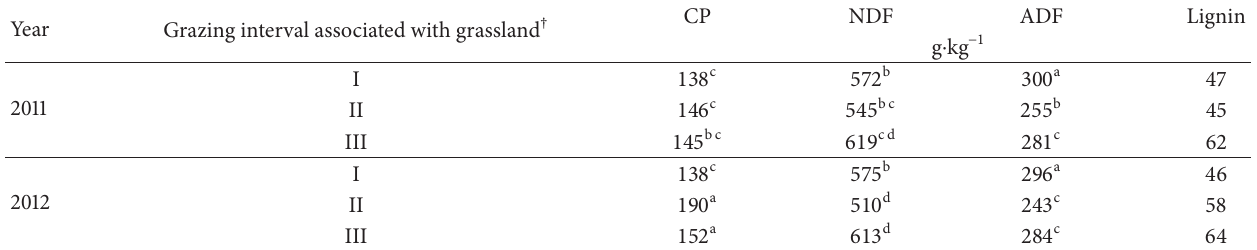
Table 6: Crude protein (CP), neutral detergent fiber (NDF), acid detergent fiber (ADF), and lignin of forage collected from each grassland during a period of two years.